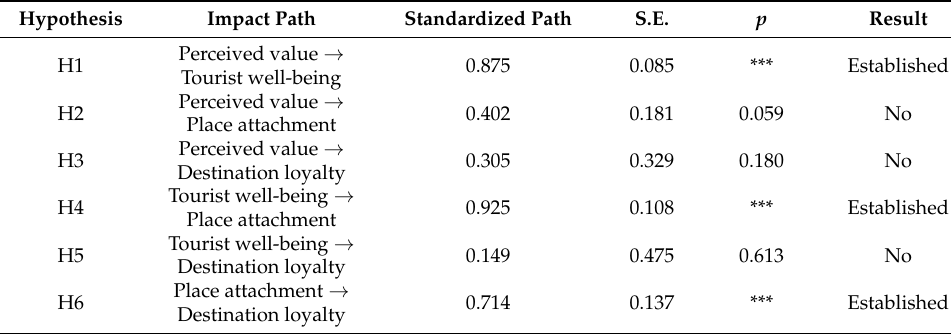
Figure 3. Estimated structural model (cid:2871) for the HA. Table 8. Validation analysis results of model M 3